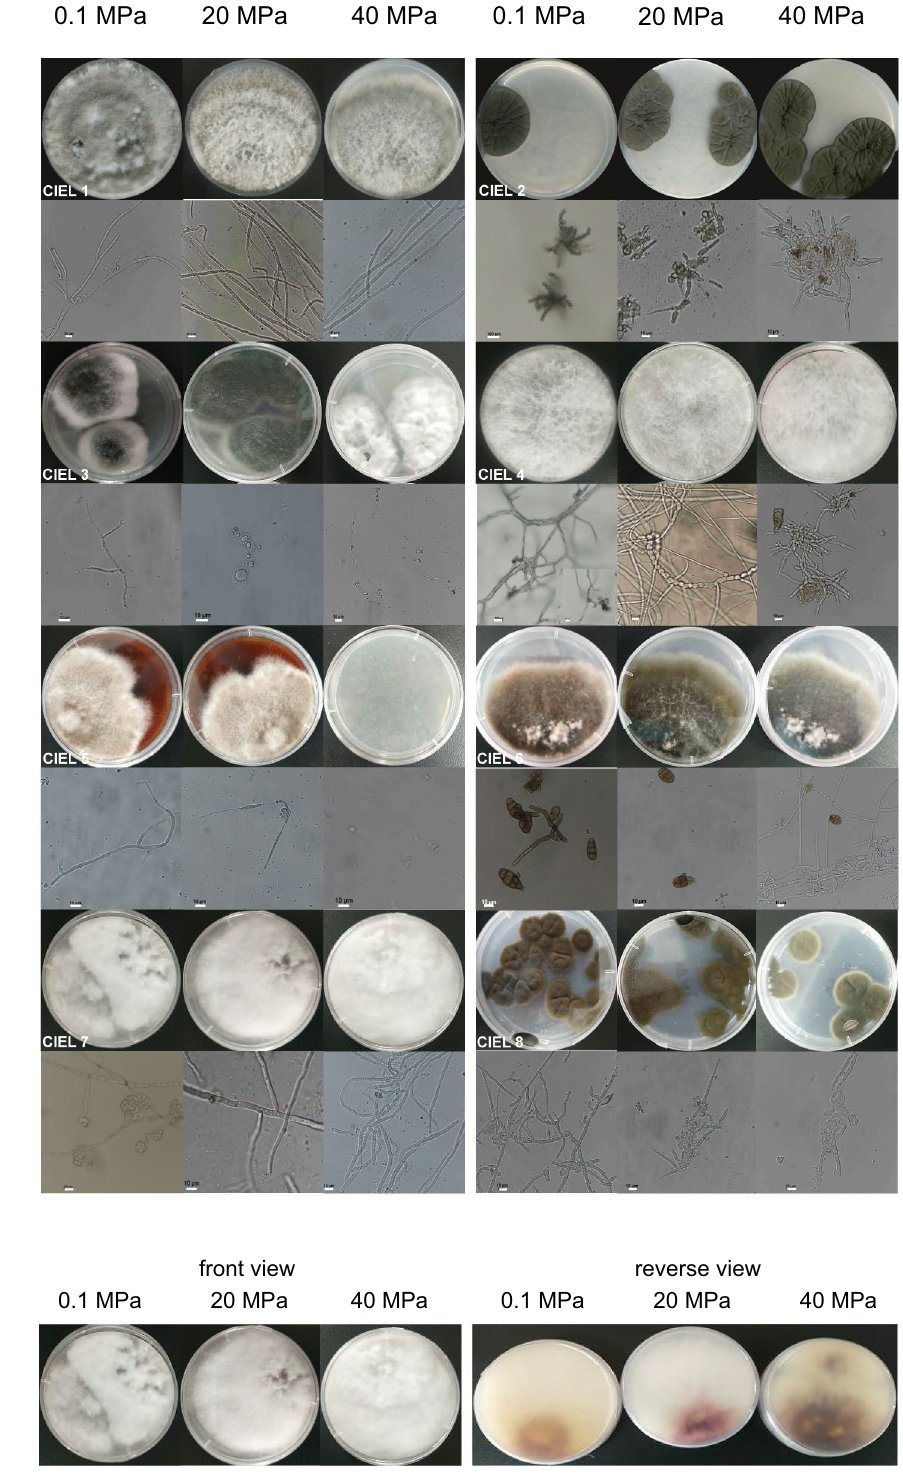
Figure 3. Phenotypes of hadal-derived fungi isolated and cultured in this experiment under the different preset pressures. ( a ) Colony, mycelium and spore morphology of eight fungi were obtained, respectively, under 0.1, 20 and 40 MPa. (CIEL 1) Alternaria alternata CIEL1, (CIEL 2) Cladosporium sp. CIEL 2, (CIEL 3) Aspergillus sp. CIEL 3, (CIEL 4) Arthrinium sp. CIEL 4, (CIEL 5) Stemphylium vesicarium CIEL 5, (CIEL 6) Alternaria sp. CIEL 6, (CIEL 7) Fusarium. poae CIEL 7, (CIEL 8) Cladosporium sp. CIEL 8. ( b ) Growth state of Fusarium poae CIEL 7 under 0.1, 20 and 40 MPa. There was no significant difference in the front side of the colonies, but the back side of the colonies showed different